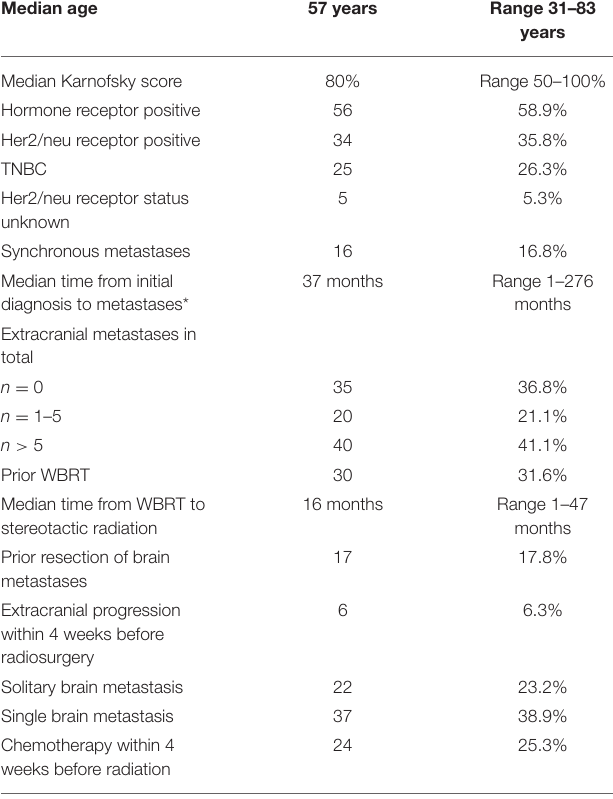
TABLE 4 | Patient characteristics ( n = 95).